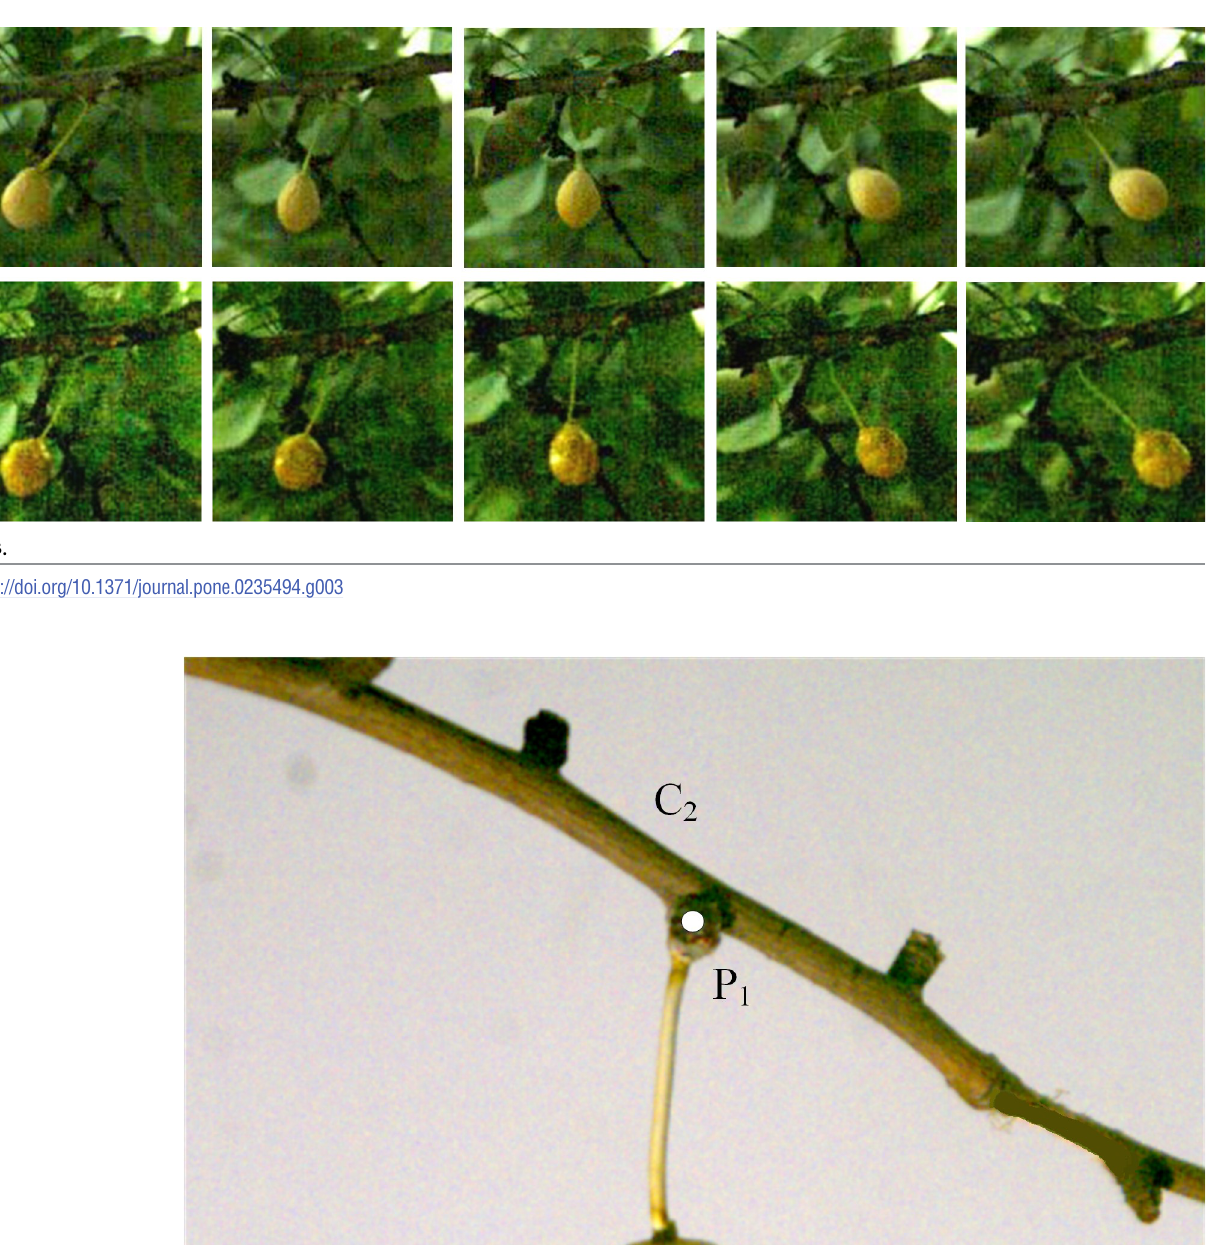
PLOS ONE | https://doi.org/10.1371/journal.pone.0235494 July 23,